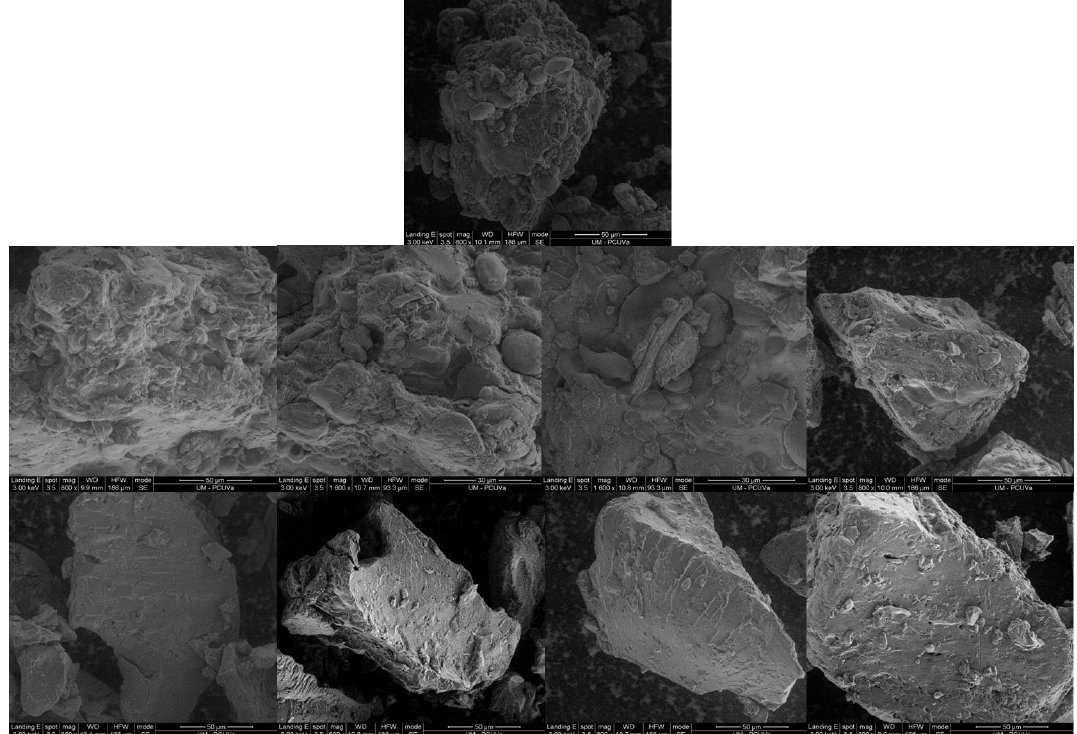
Figure 1. Microstructure of crumb and crust flours. In the upper part, regular flour; in the middle row, crust flours; and in the lower row, crumb flours. From right to left, loaf of bread with additives, “candeal” white bread, wholemeal loaf and pan loaf.